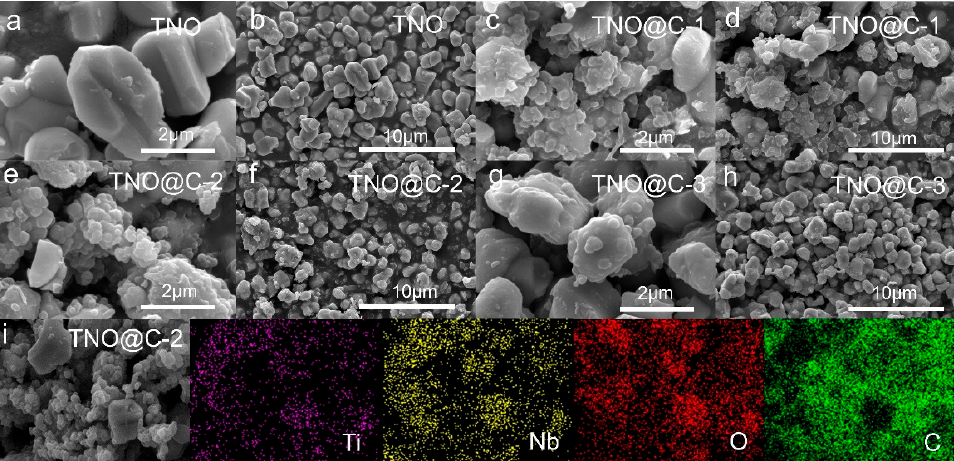
Figure 3 . SEM images of ( a , b ) TNO, ( c , d ) TNO@C-1, ( e , f ) TNO@C-2 and ( g , h ) TNO@C-3. ( i ) EDS mapping of Ti, Nb, O, and C elements.